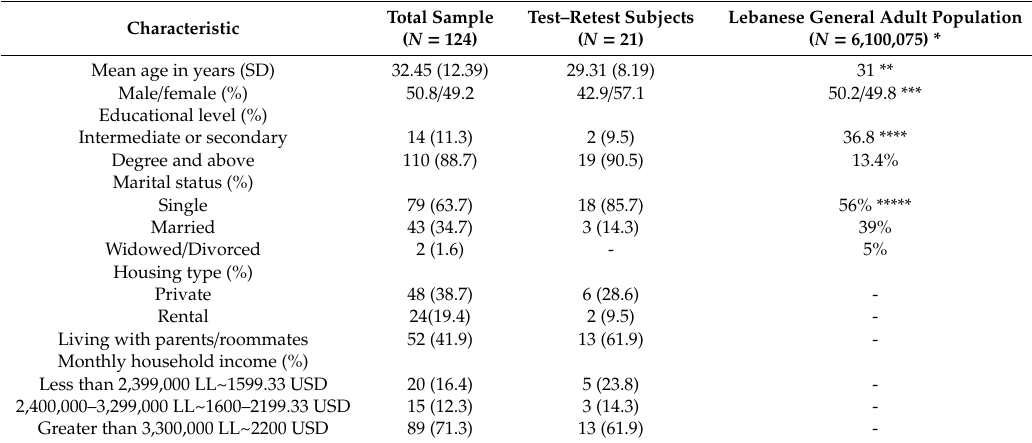
Table 1. Sociodemographic characteristics of respondents.